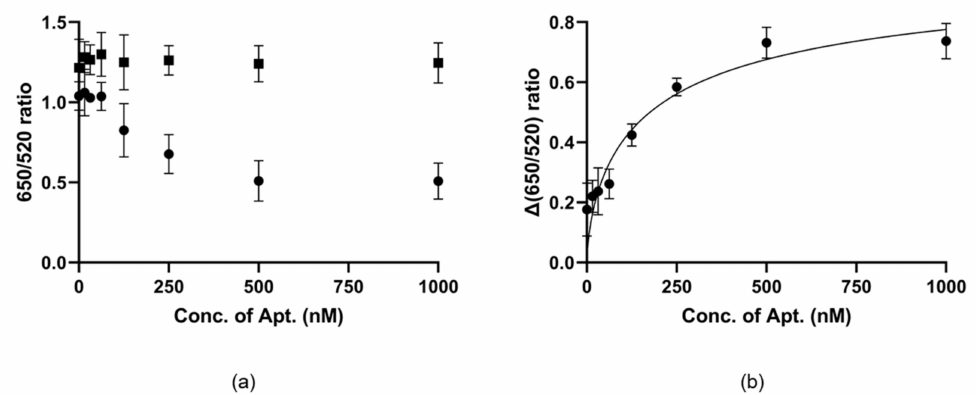
Figure 2. The binding a ffi nity of NP7 in the AuNPs colorimetric assay. ( a ) UV absorbance ratio of control line which is without the target material (solid square, top) and test line which is with the target material (solid sphere, bottom). ( b ) Di ff erences in UV absorbance ratio of control and test